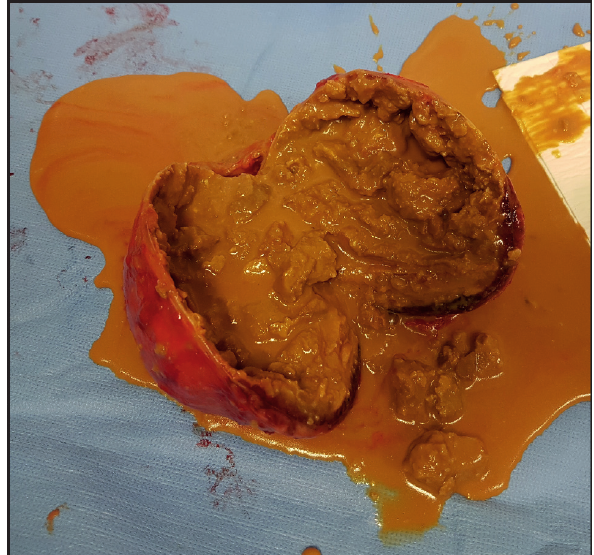
Fig. 7. Photo of gross surgical postoperative specimen demon- strates spherical shape, smooth margin, central necrosis, and peripheral rim of vital